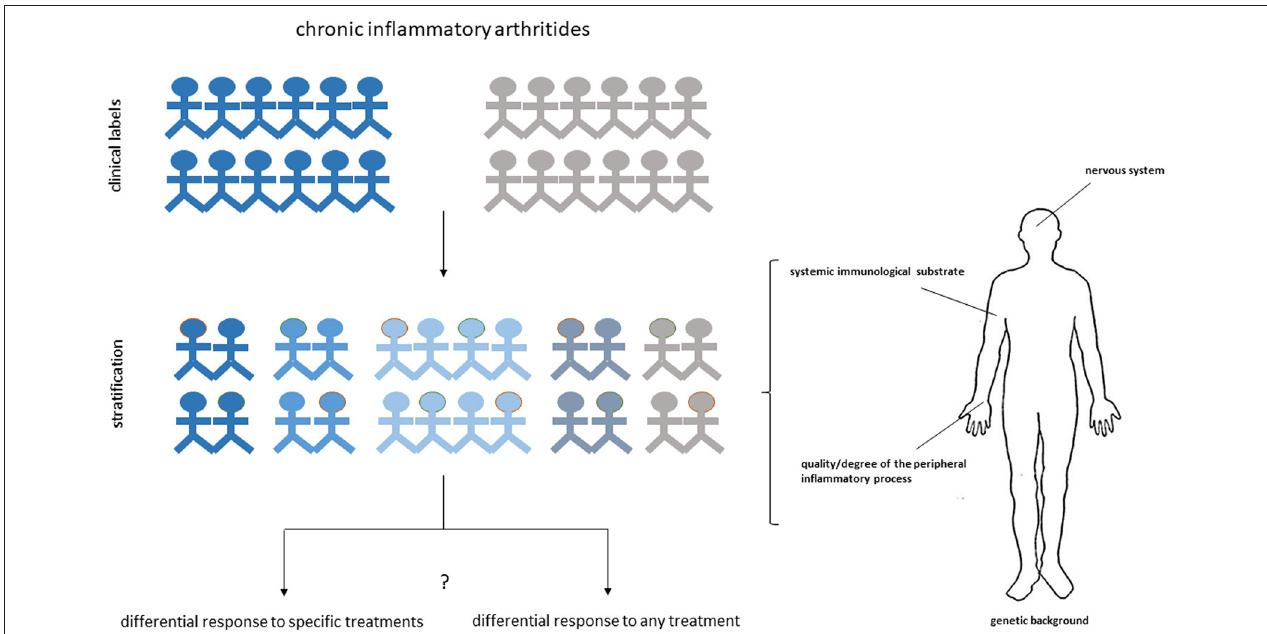
FIGURE 1 | Multidimensional approach for personalized medicine in arthritis. Different anatomic and functional dimensions can cooperate to delineate the heterogeneous phenotype of chronic inflammatory arthritides and the predisposition of subgroup of patients to respond to specific treatments or to respond to any treatment. Dissecting the synovial histological and molecular characteristics of each individual patient may provide a fundamental contribution to the stratification process by offering a privileged window on the differential expression of the disease at target